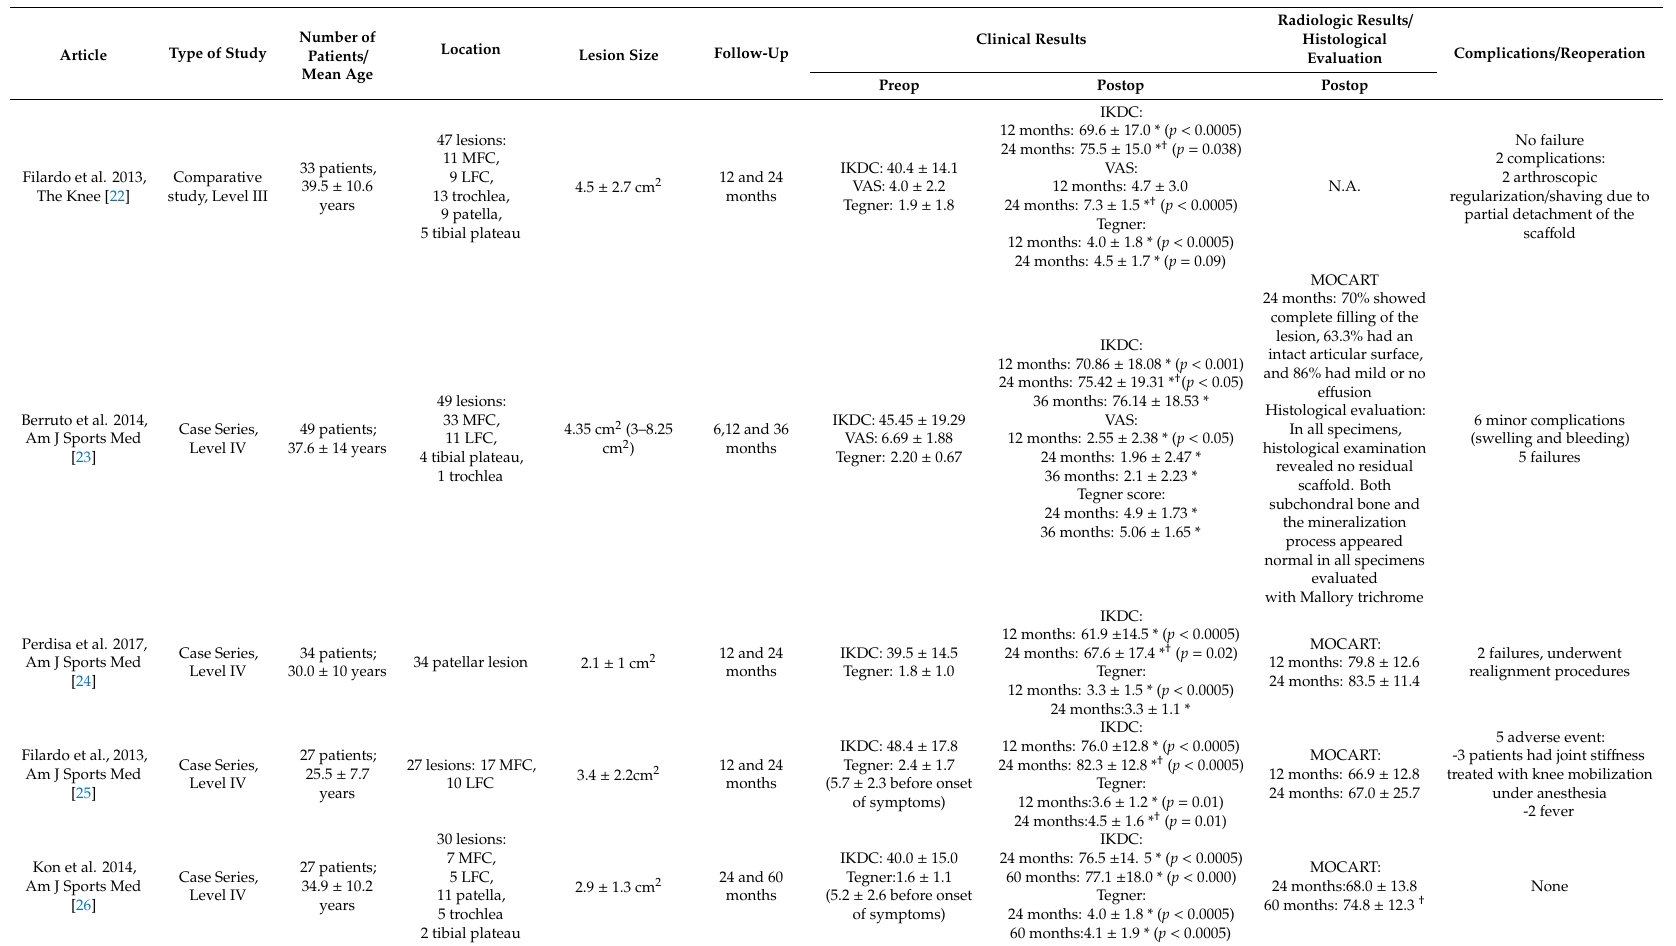
5 adverse event: -3 patients had joint sti ff ness treated with knee mobilization under anesthesia -2